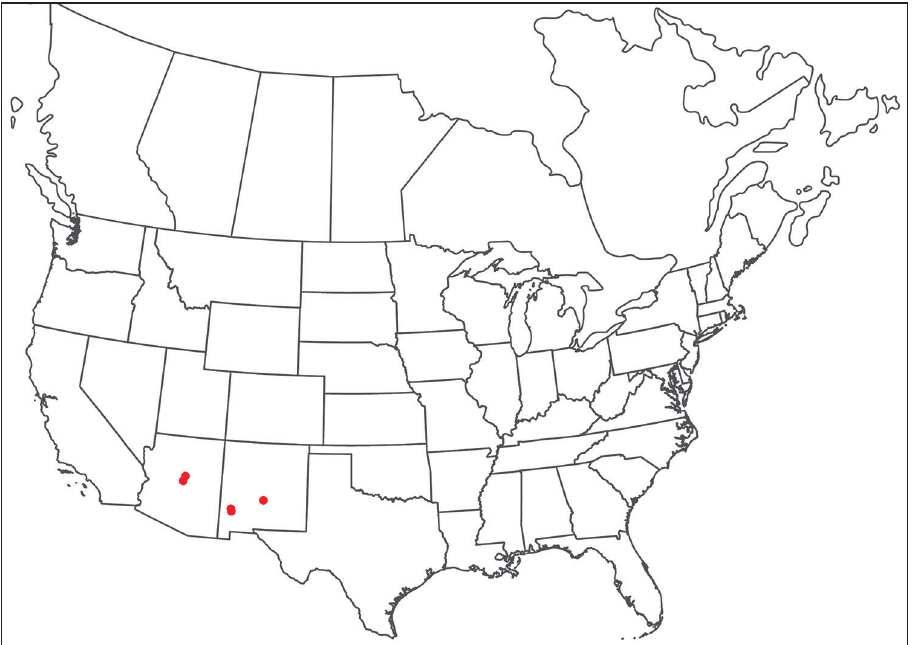
Figure 234. Torrenticola sharkeyi sp. n.